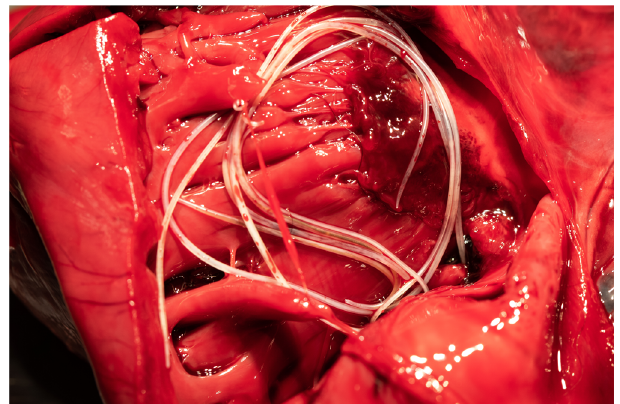
Figure 2. Heartworm ( Diro fi laria immitis ) in the right ventricle of dog No.